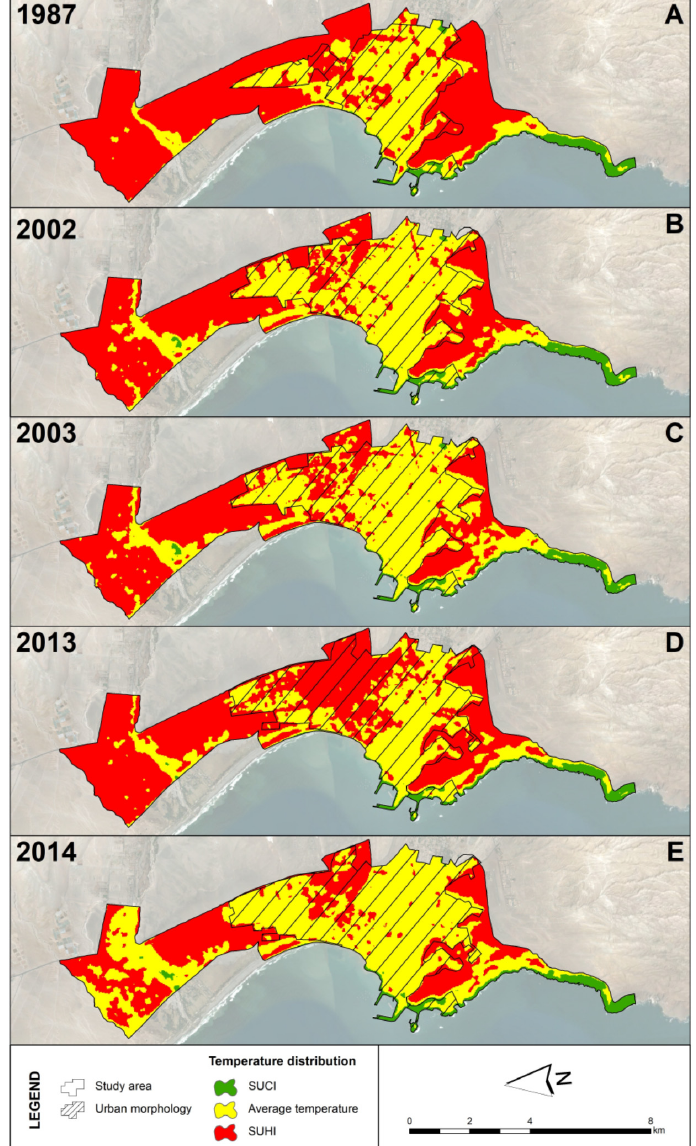
Figure 2. Locations of SUHI and SUCI and their spatial distribution in Arica during the warmer years: ( A ) 1987, ( B ) 2002, ( C ) 2003, ( D ) 2013, and ( E ) 2014. For the year 1990, the SUHI had a covered 0.10 km 2 (0.2%), while the SUCI extended over 29.36 km 2 (63.3%). The urban morphology extended over 17.10 km 2 , where average temperatures reached 0.34 km 2 (2.1%) and SUCI—16.76 km 2 (97.9%). The average tempera- ture corresponded to 27.38 ◦ C, calculated from four warm season images (Figure 3A). The lowest presence of SUHI was seen in 1991, where it extended over 0.06 km 2 (0.1%) of the study area and SUCI covered 29.28 km 2 (63.1%). The urban concentration was equivalent to 17.56 km 2 , where 0.27 km 2 (1.5%) corresponded to average temperatures and 17.28 km 2 (98.4%) to SUCI. The average temperature corresponded to 27.37 ◦ C, obtained from three satellite images of the warm season and one of the cold season (Figure 3B). In 1996, SUHI covered 0.36 km 2 (0.8%) of the area, while the SUCI was concentrated over 22.44 km 2 (48.4%). Regarding the urban concentration of Arica, this is equivalent to 18.42 km 2